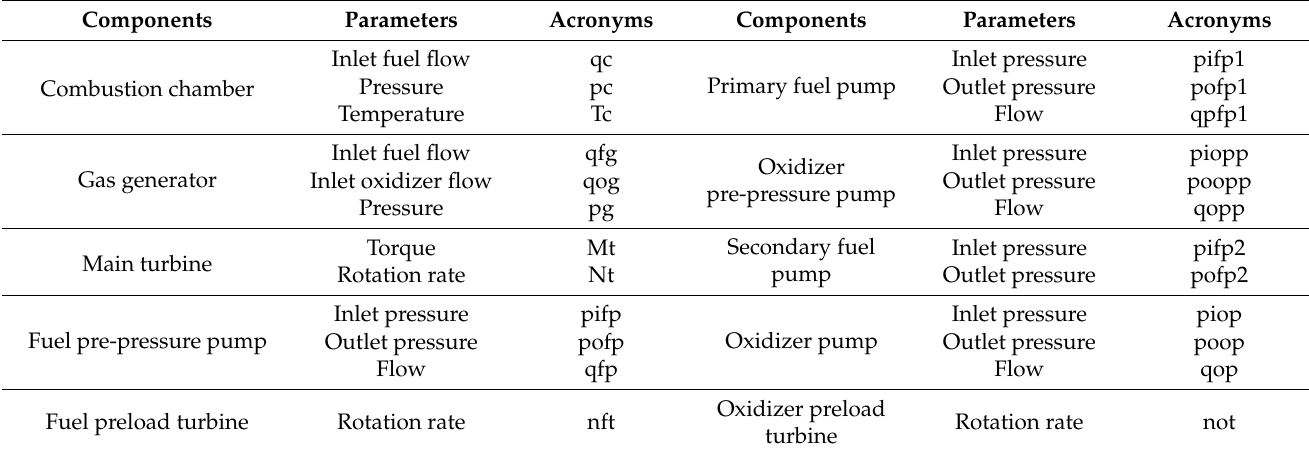
Table 2. Components of the LRE, parameters, and acronyms.